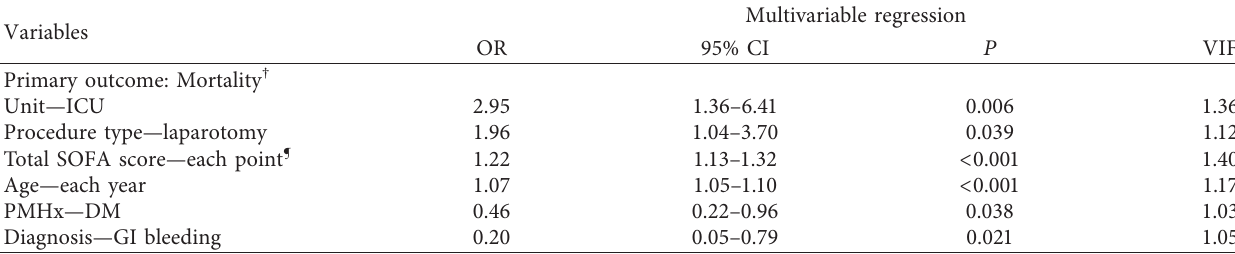
¶ Higher score indicates more severe disease. Goodness-of-fit test: † Hosmer–Lemeshow Test. Degrees of freedom: 8, χ 2 : 2.82, P � 0 . 95. CI: confidence interval; DM: diabetes mellitus; GI: gastrointestinal; ICU: intensive care unit; OR: odds ratio; PMHx: past medical history; SOFA: Sequential Organ Failure As- sessment; and VIF: variance inflation